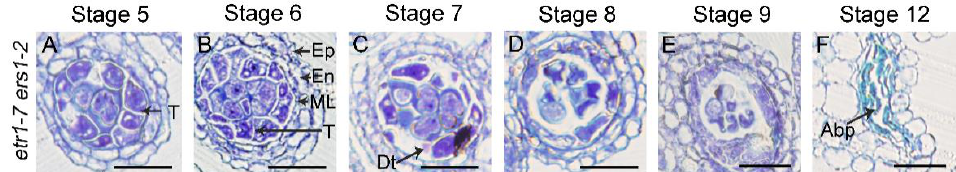
Figure 4. etr1-7 ers1-2 double mutant showed abnormal tapetum and microspores. ( A – F ) Semi-thin sections of anthers from stage 5 to stage 12 of etr1-7 ers1-2 mutant. Bars = 20 µm. Ep: epidermis; En: endothecium; ML: middle layer; T: Tapetum; Dt: Degenerated tapetum; Abp: Aborted pollen.